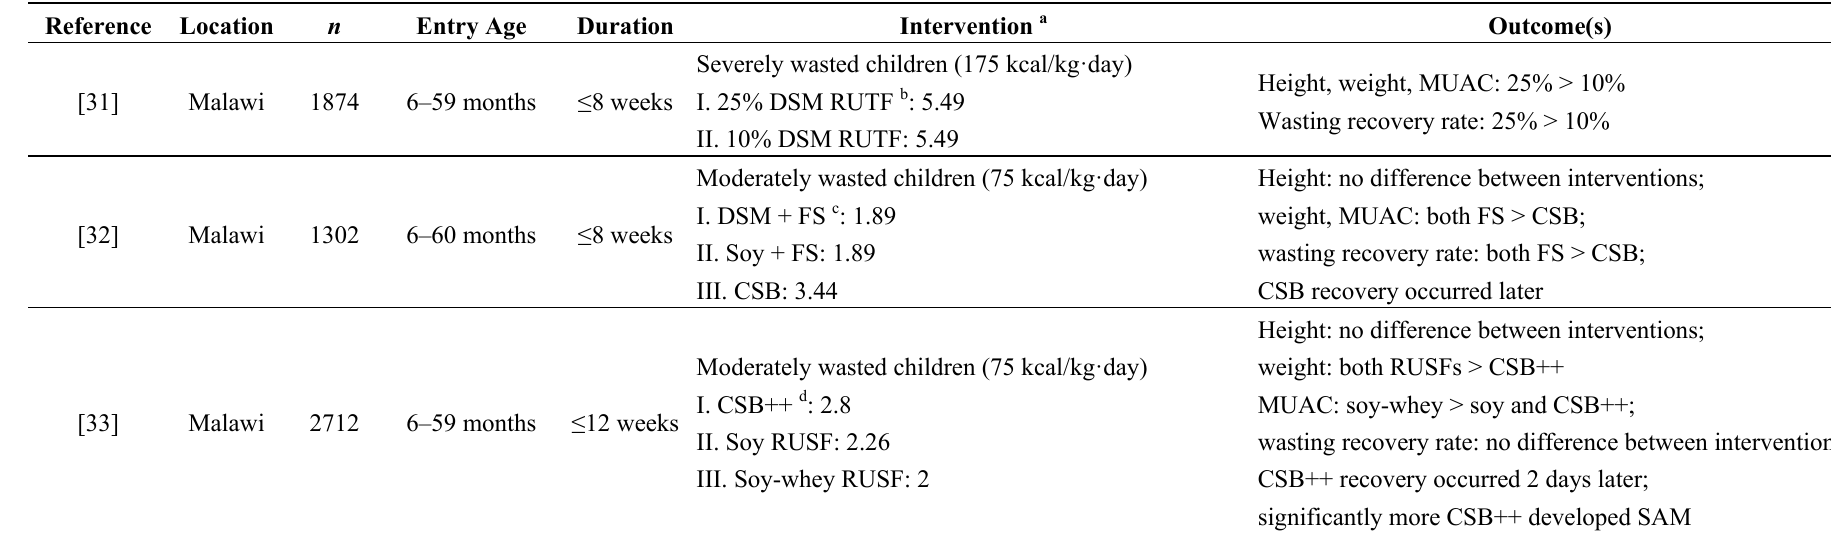
Table 4. Growth effects from isocaloric, isonitrogenous animal source food (ASF) vs. non-ASF